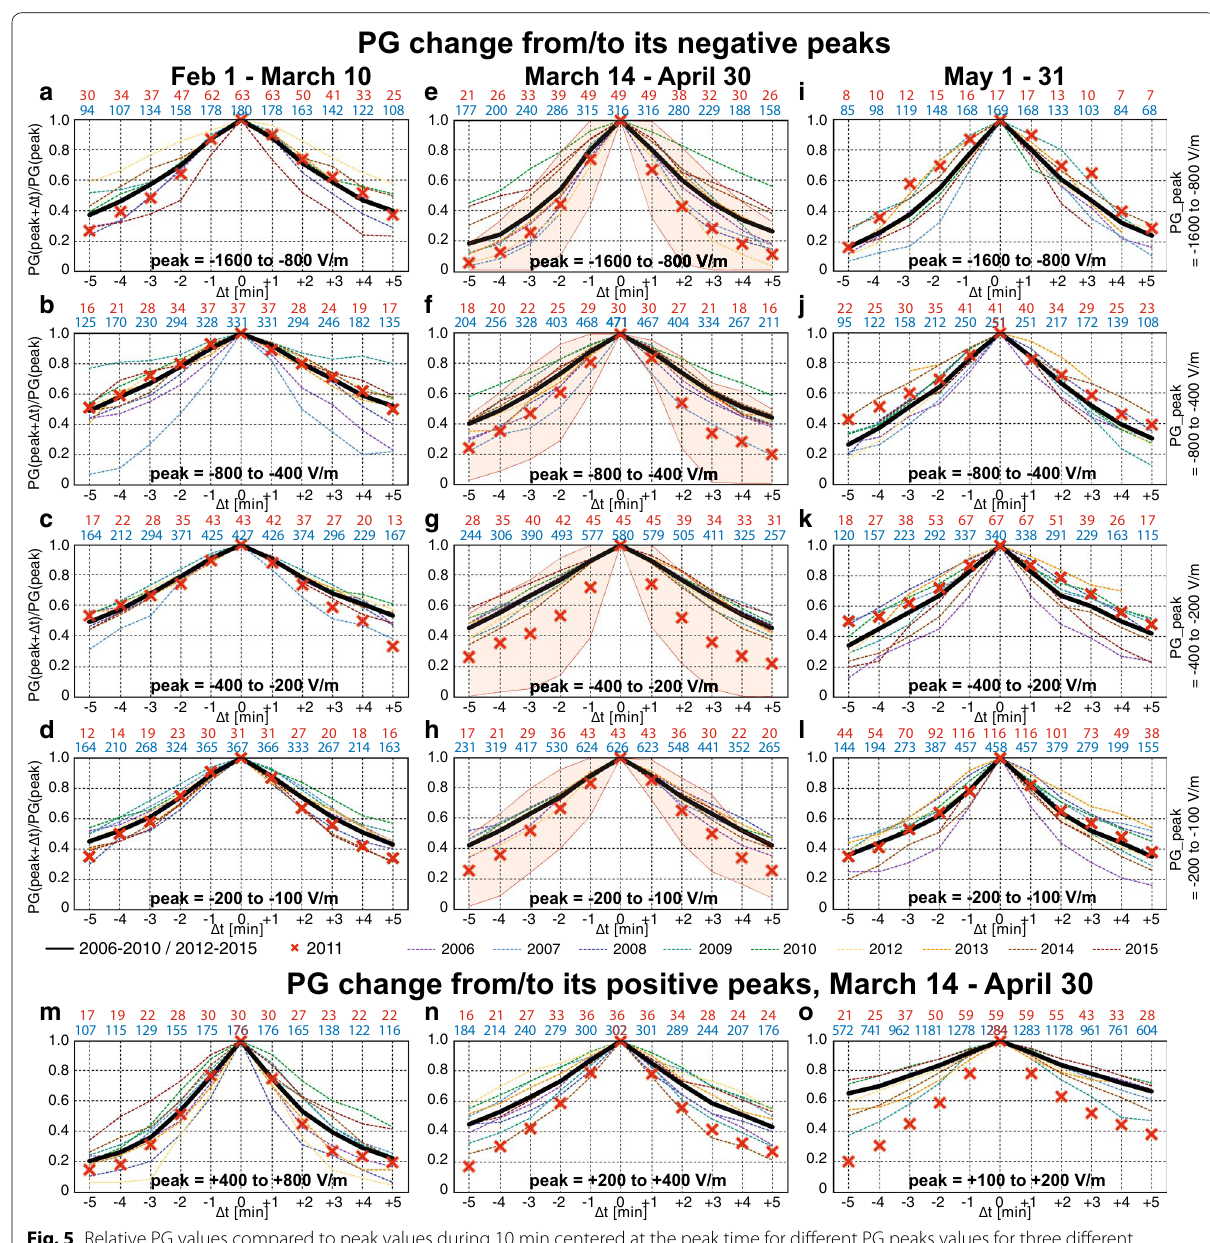
Fig. 5 Relative PG values compared to peak values during 10 min centered at the peak time for different PG peaks values for three different periods of a year. From top raw to fourth raw are negative peaks: a , e , i − 1600 < PG peak < − 800V/m , b , f , j − 800 < PG peak < − 400V/m , c , g , k − 400 < PG peak < − 200V/m , and d , h , l − 200 < PG peak < − 100V/m . The red-hatched area is range of standard deviation at each point of 2011 data. The bottom raw is for positive peaks from mid-March to April: m + 400 < PG peak < + 800V/m , n + 200 < PG peak < + 400V/m , and o + 100 < PG peak < + 200V/m . Numbers of data point of each minute are given at the top of each panel with red text for 2011 and blue text for the other years. Data point with six samples or more are plotted. In all panels, red crosses are for 2011, dashed lines are for the other years, and the thick line is for the